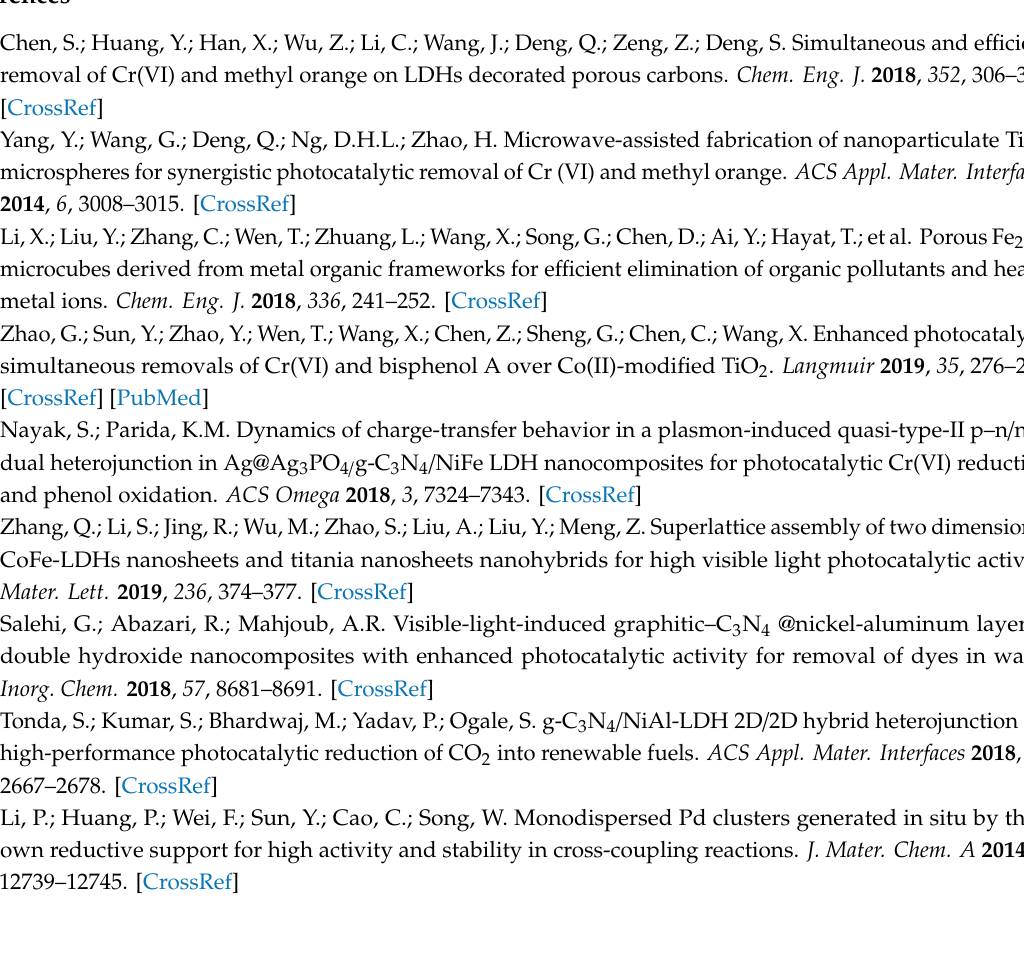
Table S1: XPS Peak positions for Fe 3 + obtained from LDH films and Fe-doped LDH films. Figure S1: XRD patterns. (a) NiAl–LDH films, (b) NiFe–LDH films, (c) Fe-doped NiAl–LDH films, and (d) Fe-doped NiFe–LDH films. Figure S2: SEM images. (a) NiAl–LDH powders, (b) NiFe–LDH powders, (c) Fe-doped NiAl–LDH powders, and (d) Fe-doped NiFe–LDH powders. Figure S3: XRD patterns. (a) NiAl–LDH powders, (b) Fe-doped NiAl–LDH powders, (c) NiFe–LDH powders, and (d) Fe-doped NiFe–LDH powders. Figure S4: EDS elements mapping for Fe-doped NiAl–LDH films after the photocatalytic degradation in the presence of methyl orange (20 mg · L − 1 ) and Ag ions (5 mg · L − 1 ). (a) Area without Ag particles, (b) area with Ag particles. Figure S5: EDS spectra for Fe-doped NiAl–LDH films after photocatalytic reaction in the presence of 5 mg · L − 1 Ag ions. (a) Area with Ag nanoparticles, (b) area without Ag nanoparticles in Figure 7c. Figure S6: N 2 adsorption / desorption isotherms of (a) NiAl–LDH powders and Fe-doped NiAl–LDH powders, (b) NiFe–LDH powders and Fe-doped NiFe–LDH